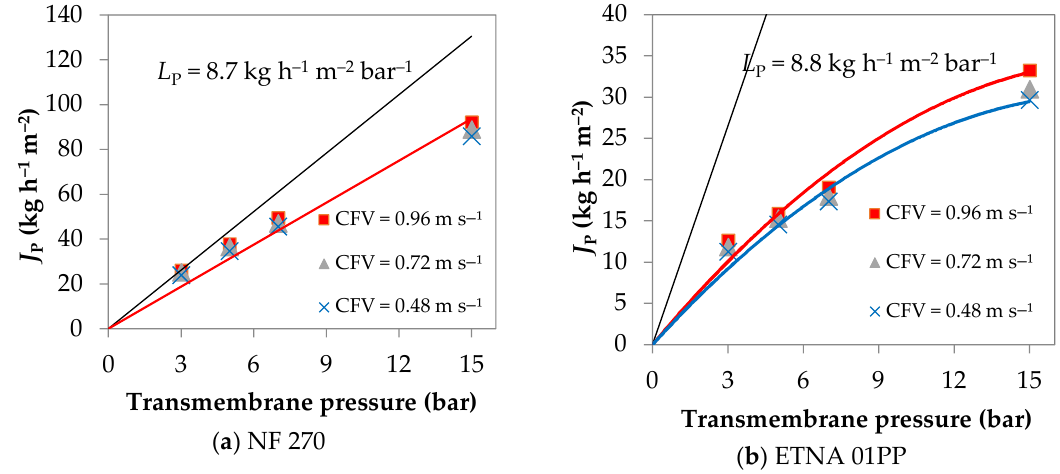
Figure 2. Permeation fluxes ( J P ) as a function of transmembrane pressure at three cross-flow feed velocities: ( a ) NF 270 membrane; ( b ) ETNA 01PP membrane.